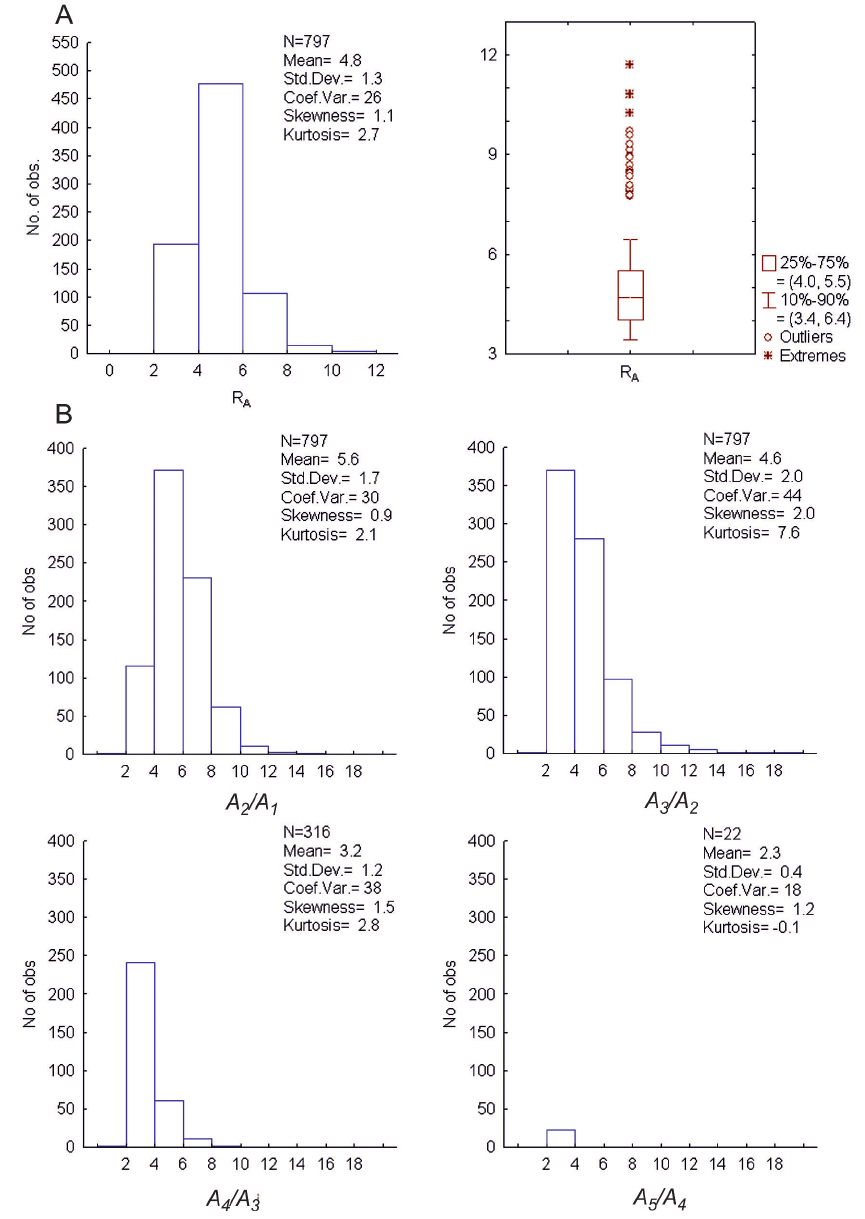
Fig. 5. The area ratio (R ) in the investigated catchments – A, the growth rate of the area ratio – B. Labeled like fig. A